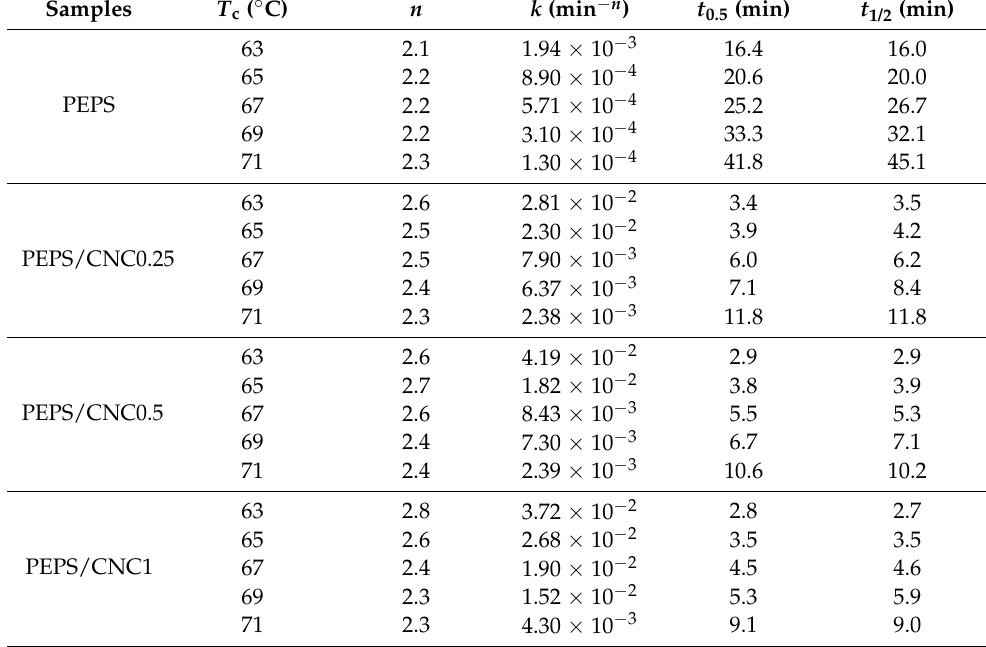
Table 1. Isothermal crystallization kinetics parameters for PEPS and PEPS/CNC composites.